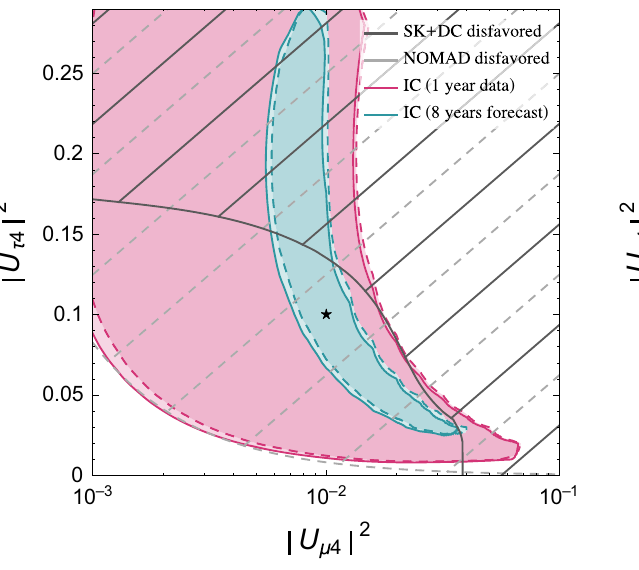
Fig. 2 Theleft(right)panelshowsinpinktheconstraintsat90%(99%) C.L. for the sterile mixing elements from the released 1-year data. The cyan region shows at the same C.L. the forecast for 8 years of IceCube data assuming as true values | U μ 4 | 2 = 10 − 2 , | U τ 4 | 2 = 0 . 1 , δ 24 = 0